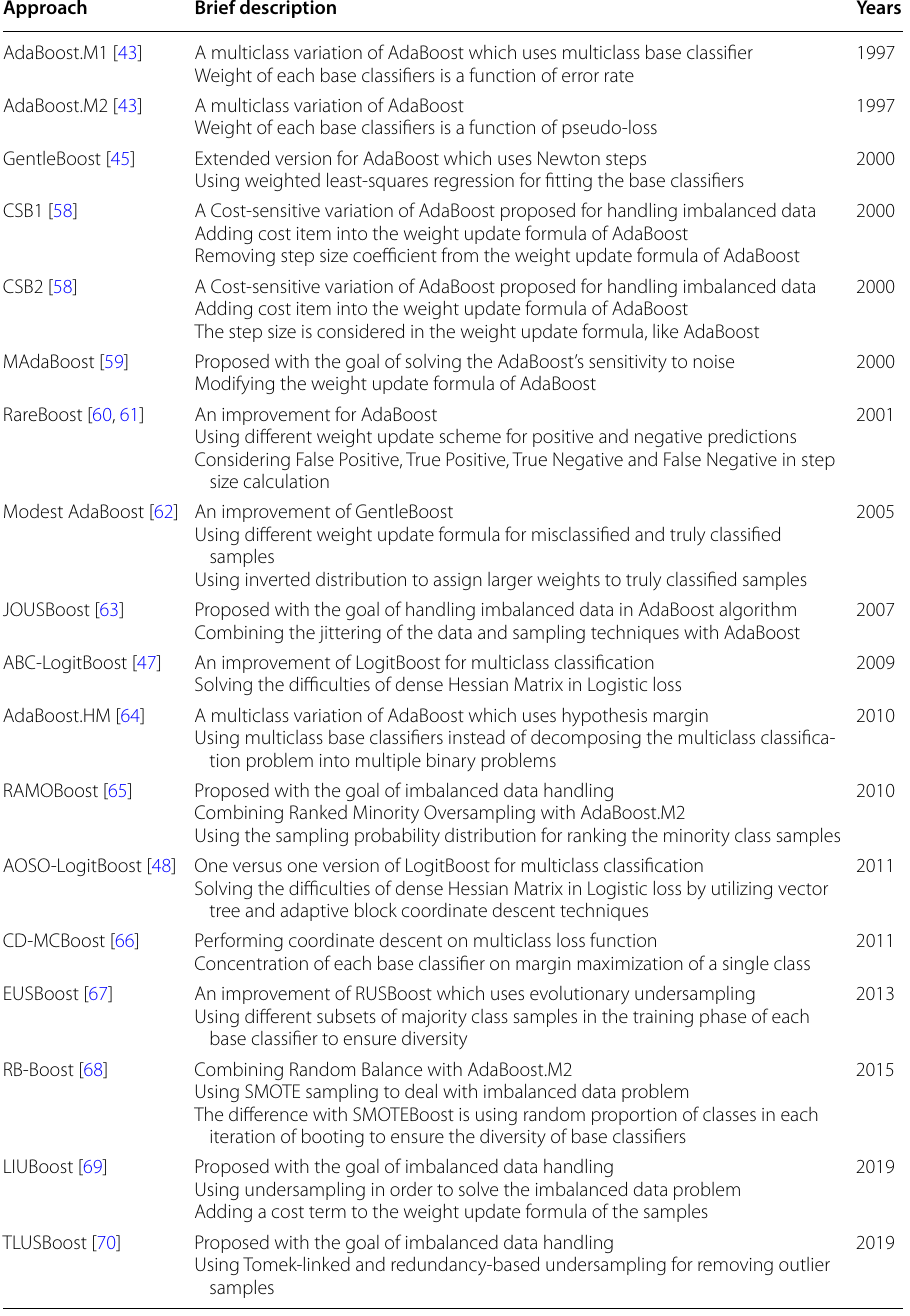
Table 1 Overview of the boosting approaches Approach Brief